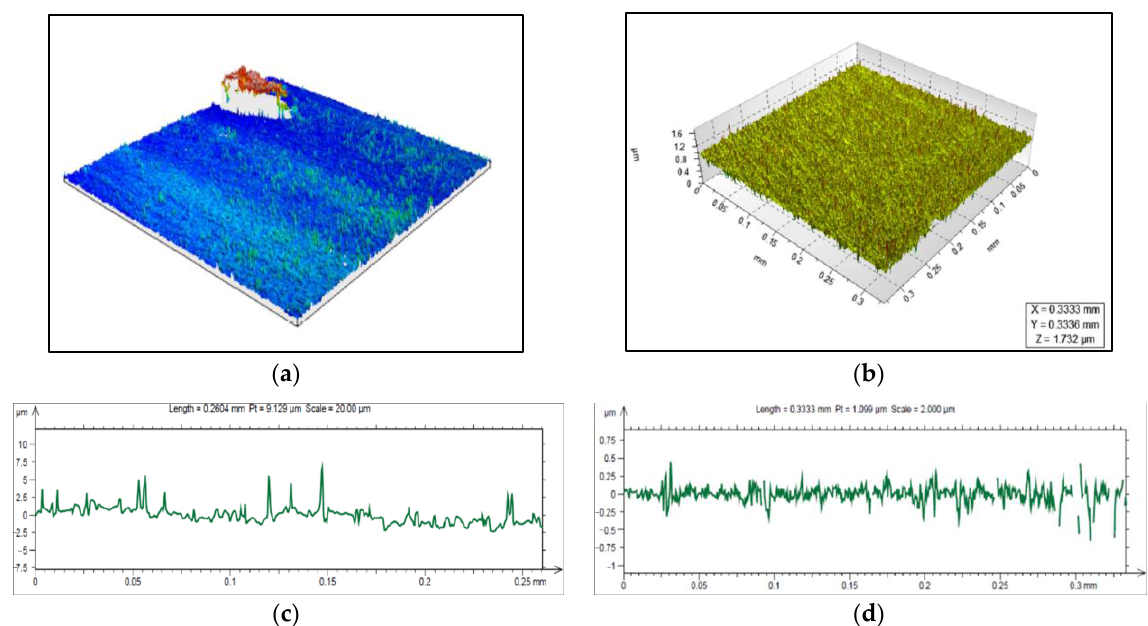
Figure 11. Differentiation of three − dimensional surface roughness, two − dimensional surface profile initially and after burnishing at 600 rpm. ( a ) 3D profile of initial surface, ( b ) 3D profile of burnished surface, ( c ) 2D profile of initial surface, ( d ) 2D profile of burnished surface.